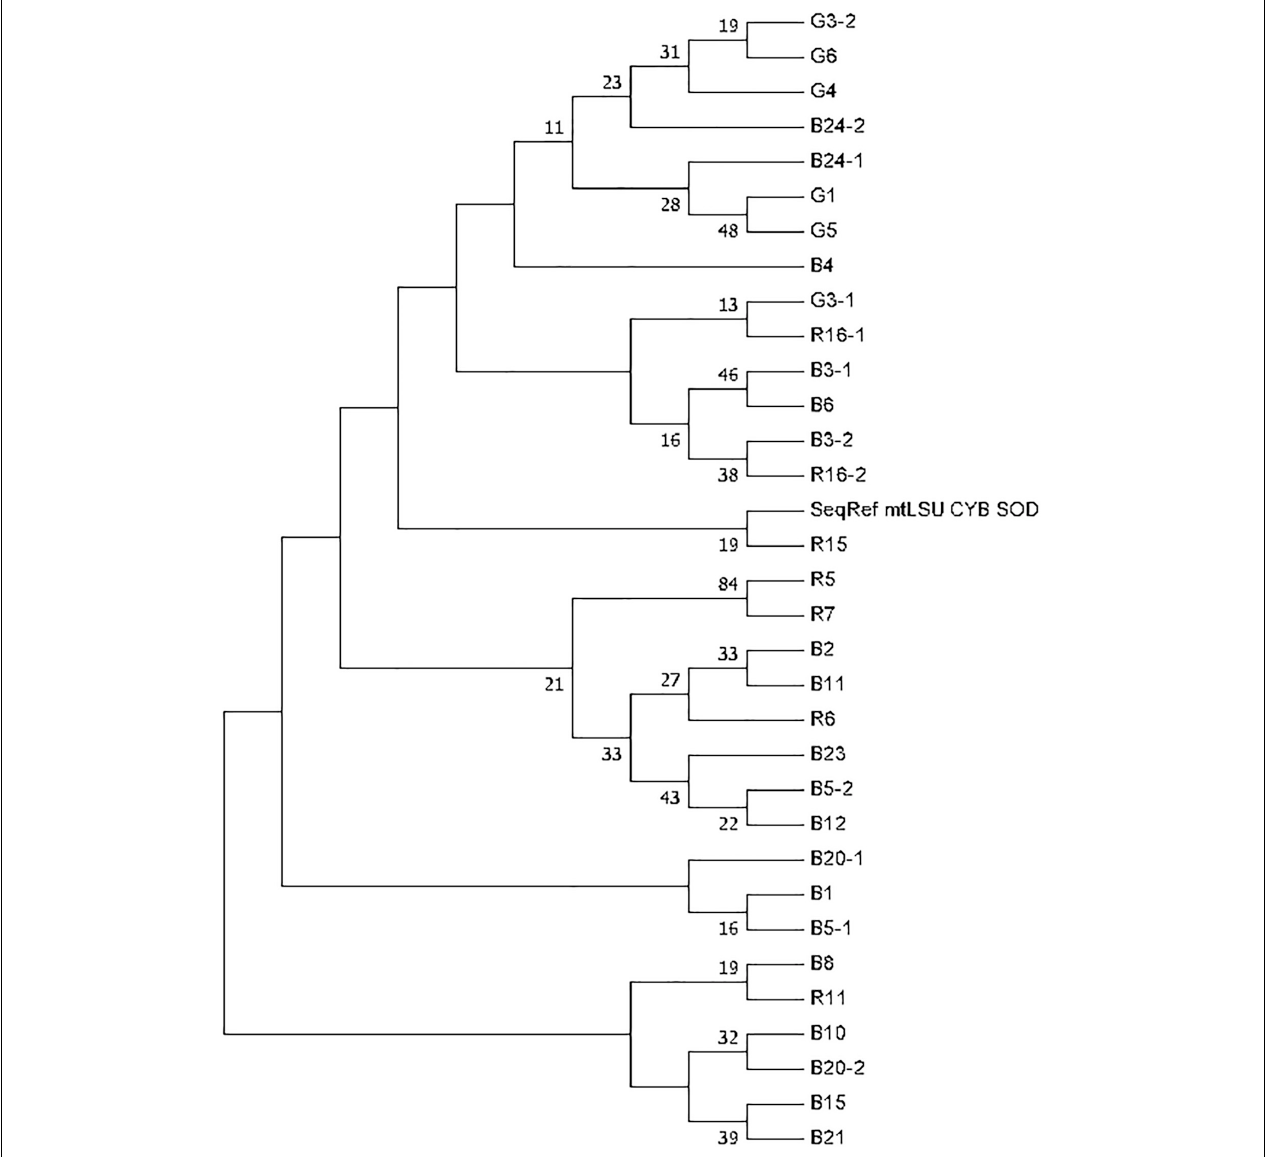
FIGURE 2 | Phylogenetic tree generated based on Pneumocystis jirovecii MLST genotypes. The tree was constructed on the basis of concatenated loci (mtLSUrRNA, CYB , and SOD ). Phylogenetic analysis used the Maximum Likelihood method based on the Hasegawa-Kishino-Yano model. The bootstrap consensus tree was inferred from 1,000 replicates. Branches corresponding to partitions reproduced in less than 50% bootstrap replicates are collapsed. The percentage of replicate trees in which the associated taxa clustered together in the bootstrap test are shown next to the branches. Only bootstrap values > 10% are shown. Initial tree(s) for the heuristic search were obtained automatically by applying Neighbor-Join and BioNJ algorithms to a matrix of pairwise distances estimated using the Maximum Composite Likelihood (MCL) approach, and then selecting the topology with superior log likelihood value. The analysis involved 33 nucleotide sequences. There were a total of 1152 positions in the final dataset. Evolutionary analyses were conducted in MEGA7. Patients and samples are identified with a letter (R for Reunionese patients, G for Guianese patients and B for Brest patients) followed by a number.